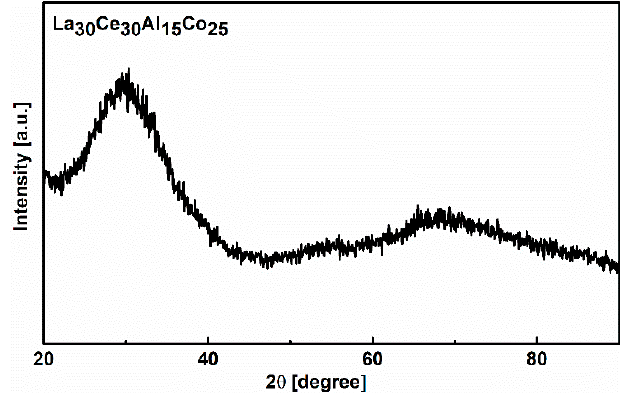
Figure 1. XRD pattern of the as-cast La 30 Ce 30 Al 15 Co 25 metallic glass.